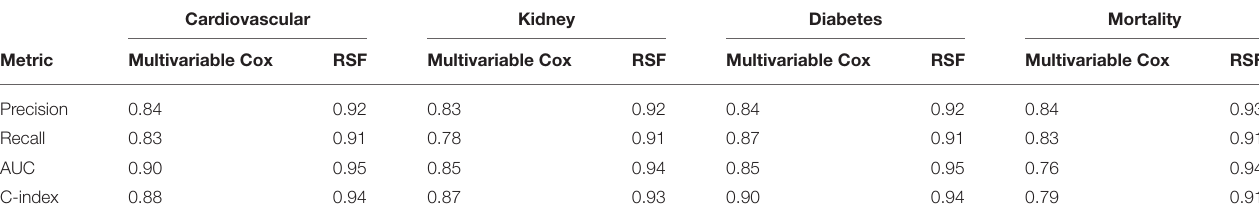
TABLE 4B | Performance comparisons between multivariable Cox and random survival forest with five-fold cross validation. Cardiovascular Kidney Diabetes Mortality Metric Multivariable Cox RSF Multivariable Cox RSF Multivariable Cox RSF Multivariable Cox RSF